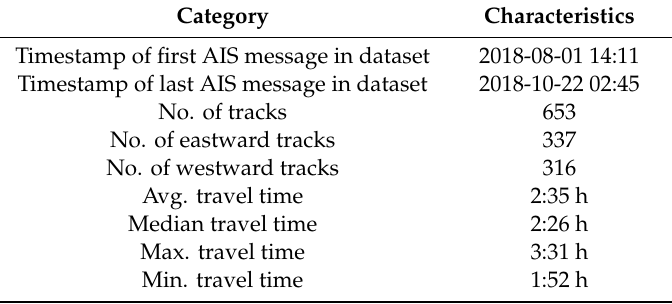
Table 1. Statistical evaluation of the lengths and widths of the ships in the dataset we use. AIS, Automatic Identification